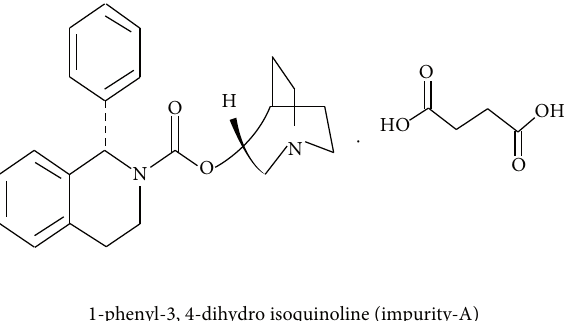
(impurity-A)(1S)-3, F 1: Chemical structures of solifenacin succinate, impurity-A, impurity-B, and impurity-C. oxide (10 mg VESIcare tablet). e recommended dose of VESIcare is 5 mg once daily. If the 5 mg dose is well tolerated, the dose may be increased to 10 mg once daily. VESIcare should be taken with water and swallowed whole. VESIcare can be administered with or without